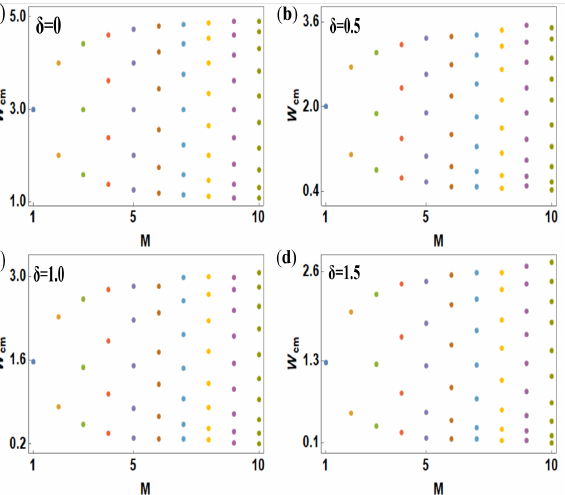
Figure 7. (Color online). Dependence of critical points W cm of phase transition on the non-Hermitian parameter δ for different stranded Aubry–André–Harper ladders. We compute the results for the BT-I case only by varying the number of strands M = 1 to M = 10. The colored dot points represent the critical disorder strengths, which follow quite a regular pattern. Four different δ values are taken into account, as typical examples, and the results are presented in ( a ), ( b ), ( c ) and ( d